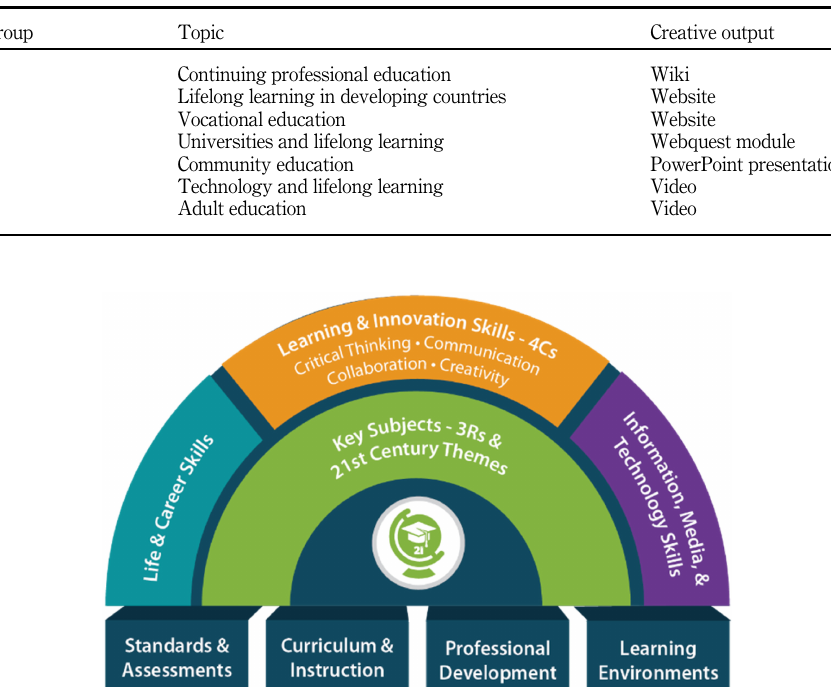
Figure 2. The P21 framework for 21st century learning reprinted with